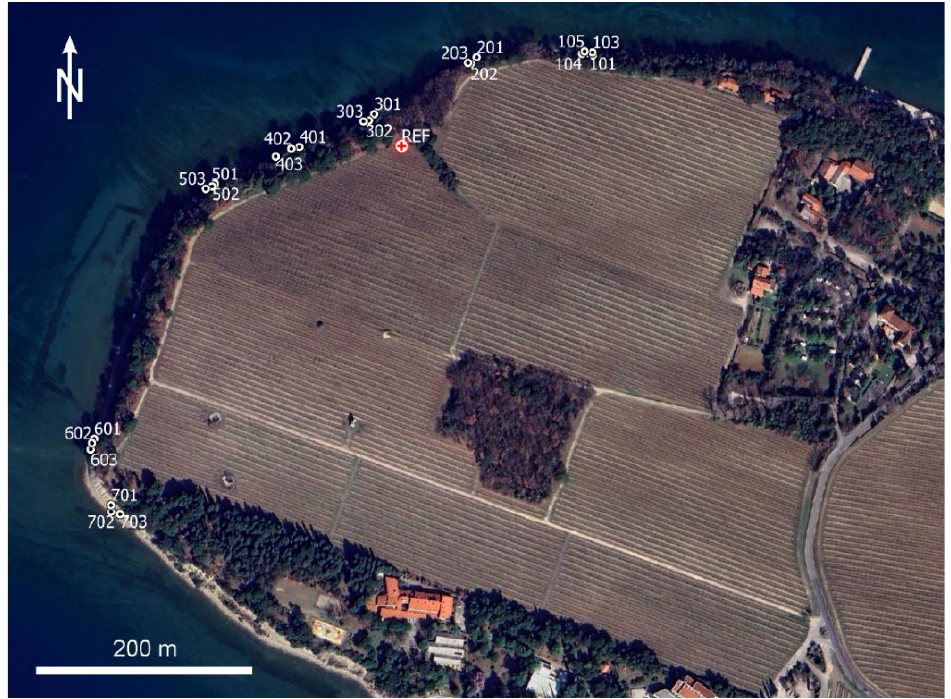
Figure 5. Spatial distribution of GCPs recorded with GNSS at some specific outcrops along the surveyed rocky coastline.